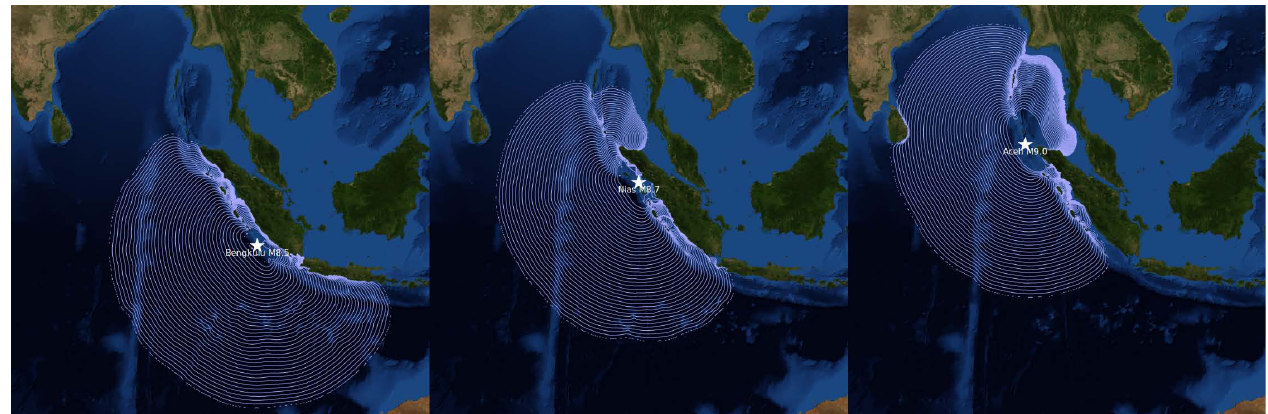
Fig. 12. Virtual scenarios with tsunami wave propagation generated by earthquake events selected in 2011 for testing, demonstration and validation of Indonesian system as well as used for training: Bengkulu, left) based on historic event in 2007, according to Lorito et al. (2008), 101.09 ◦ E, 4.67 ◦ S, M w = 8.5; Nias, middle) based on historic event in 2005, according to Babeyko et al. (2010), 97.29 ◦ E, 1.88 ◦ N, M w = 8.7; Aceh, right) fictitious event similar to historic event in 2004, according to Hoechner et al. (2008), 94 ◦ E, 5.8 ◦ N, M w = 9.0.